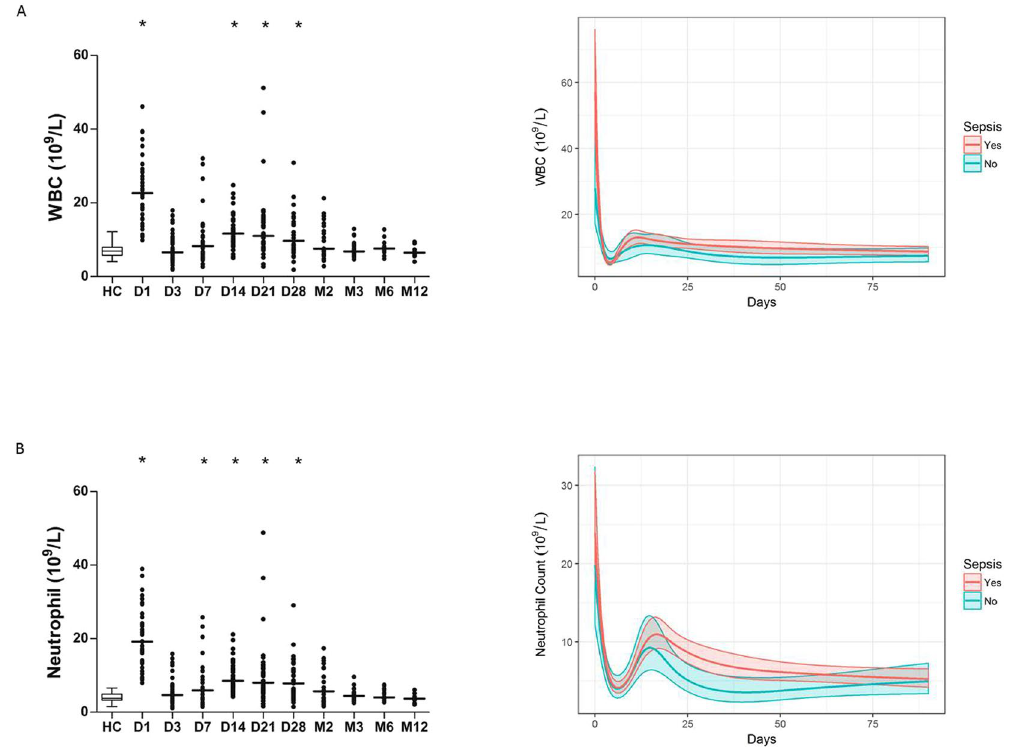
Figure 4. Circulating levels of white blood cells (WBC) and neutrophils are elevated post thermal injury. ( A ) White blood cell count (WBC) across time (n = 39). ( B ) neutrophil count across time (n = 39). Differences in kinetics were compared to data from control cohort (n = 40) using a Mann-Whitney test; * p < 0.005. Longitudinal analyses were performed using linear mixed-effects models to examine the relationship between time and WBCs or neutrophil count (n = 39). Line represents predicted mean fixed effects; shaded area represents 95% confidence